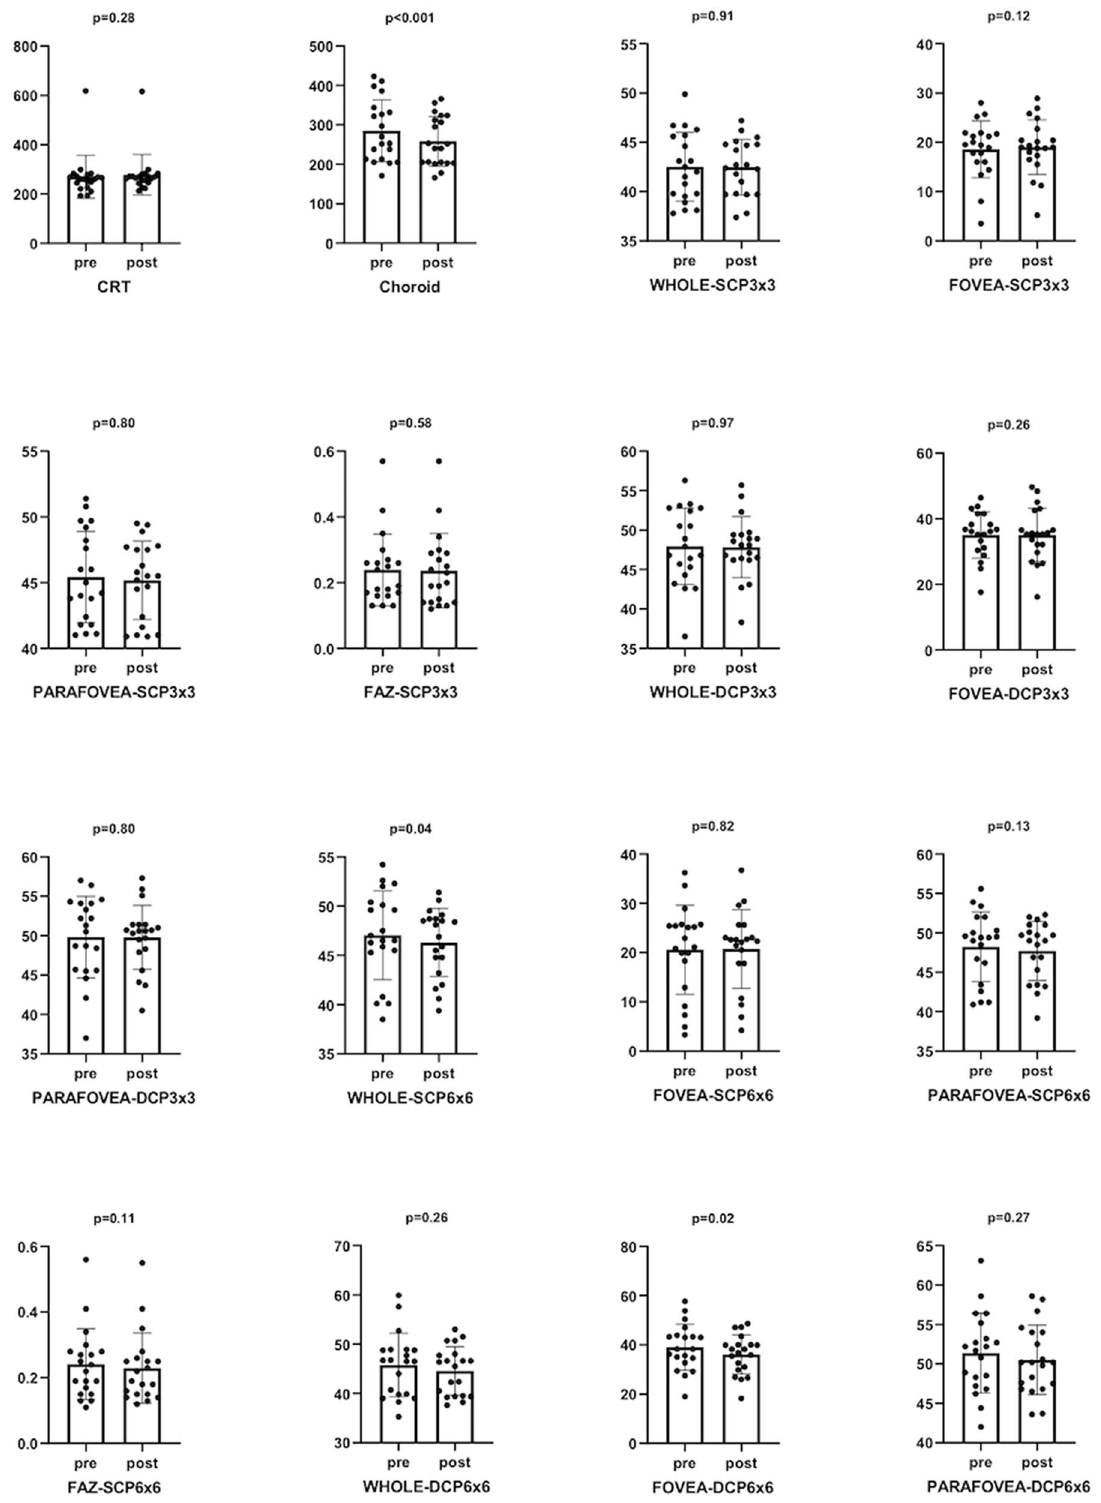
Figure 2. Pre-post dialysis variations in OCT-A metrics. A more prominent significant drop was found in choroidal parameters (Choroid p < 0.001, WHOLE-SCP6X6 and FOVEA-DCP6X6 p < 0.05) respect to retinal